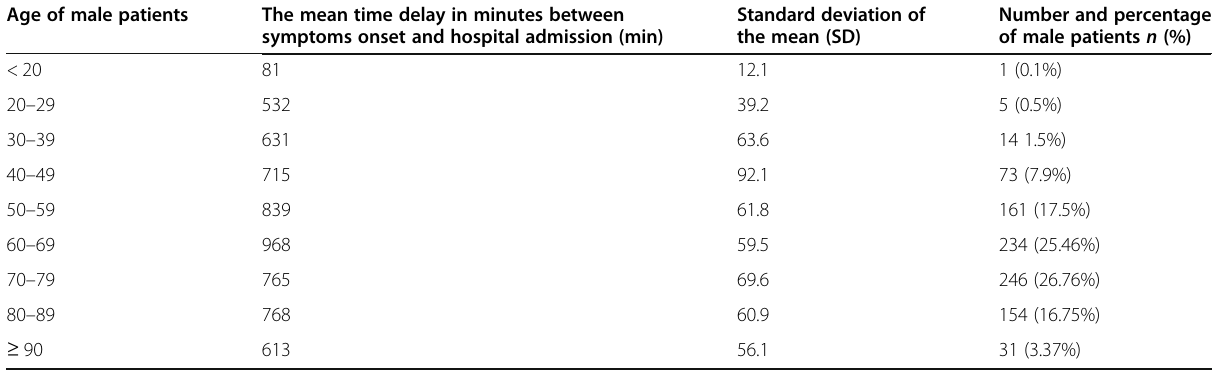
Table 4 It demonstrates delays between onset of symptoms and arrival at the hospital in men of different age groups Age of male